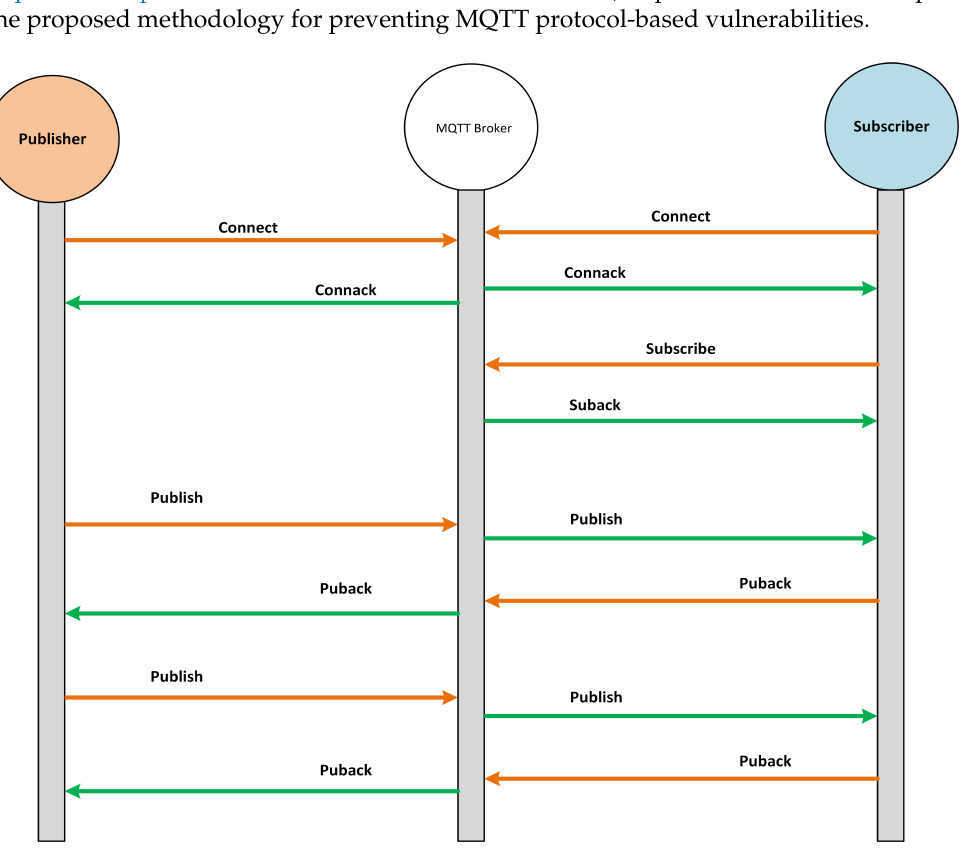
Figure 5. MQTT subscribe packet flow when RET flag is True and QoS is set to 2